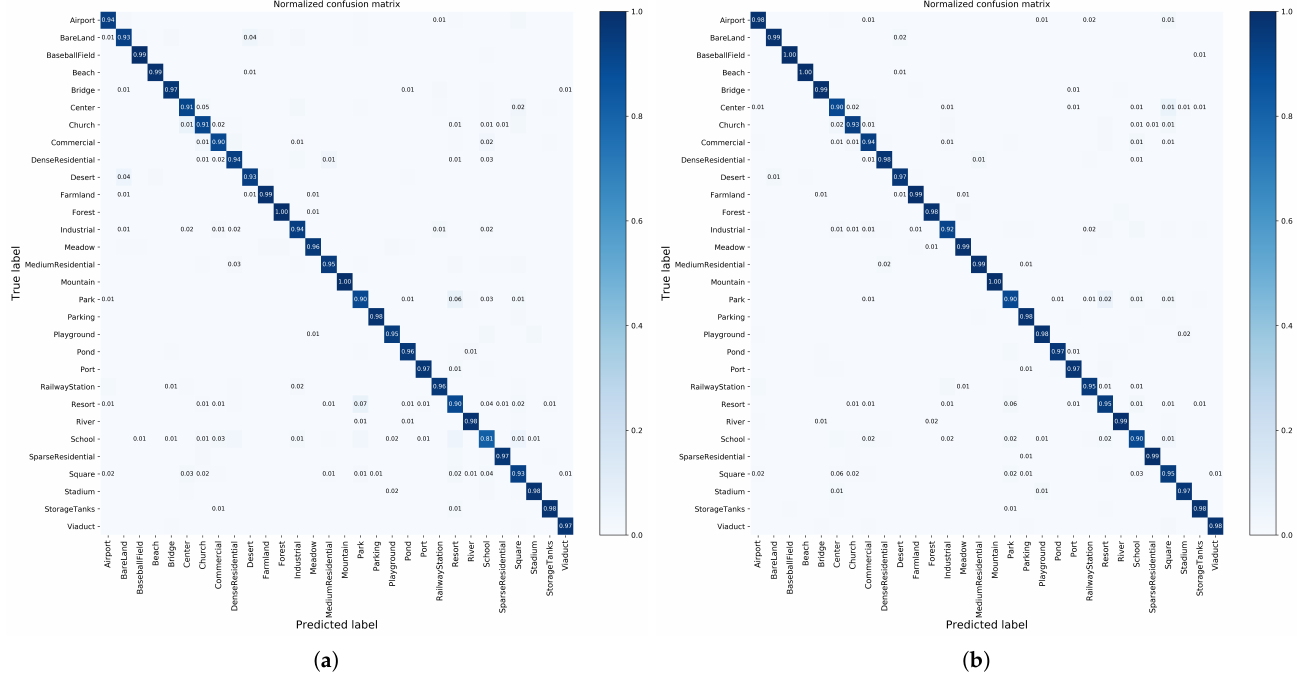
Figure 9. CMs on AID. ( a ) Training ratio = 20% (accuracy = 95.14%). ( b ) Training ratio = 50% (accuracy =